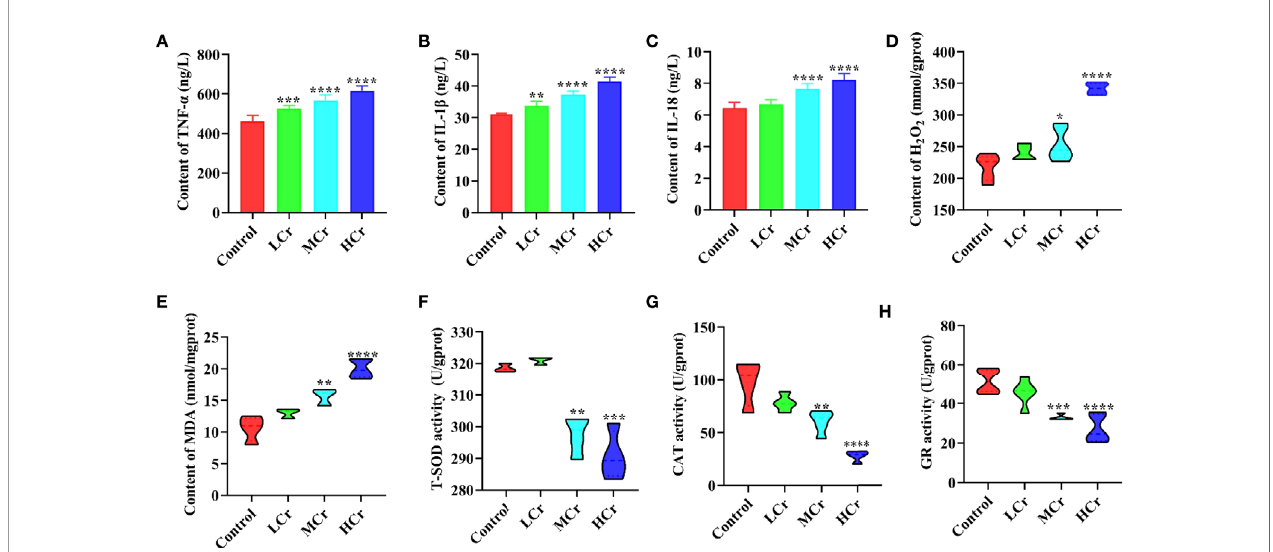
FIGURE 3 | The effects of Cr(VI) on in fl ammation and oxidative stress in the jejunum. (A) TNF- a concentration. (B) IL-1 b concentrations. (C) IL-18 concentrations. (D) H 2 O 2 concentrations. (E) MDA concentrations. (F) T-SOD activity. (G) CAT activity. (H) GR activity. The symbol “ * ” denotes a statistically signi fi cant difference from the control group (* P < 0.05, ** P < 0.01, *** P < 0.005 and **** P <